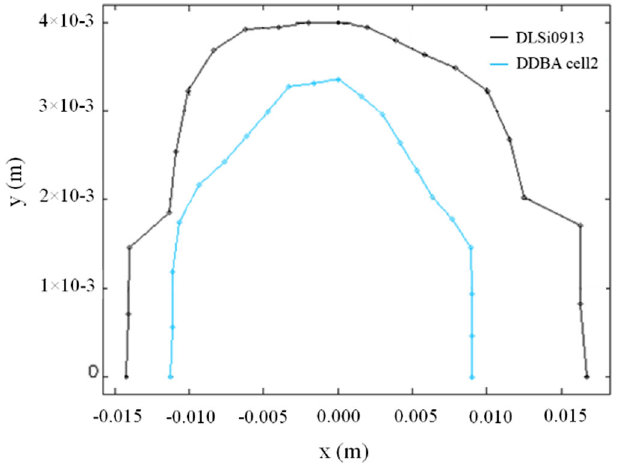
FIG. 6. Flux in the central cone for a short 0.7 m, 30.8 mm period, out-of-vacuum ID (blue), and a full length 2 m CPMU, 17.7 mm period, in the DDBA straight section